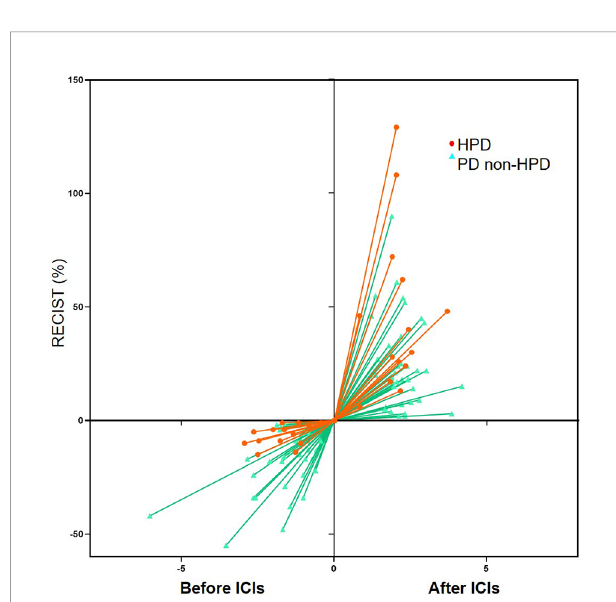
FIGURE 3 | Spider plot depicting the percent change in the sum of the longest diameters of target lesions and new lesions (RECIST) before immune checkpoint inhibitors (ICIs) and after ICIs periods in the 51 evaluable patients according to de fi nition 3. HPD, hyperprogressive disease; PD, progressive